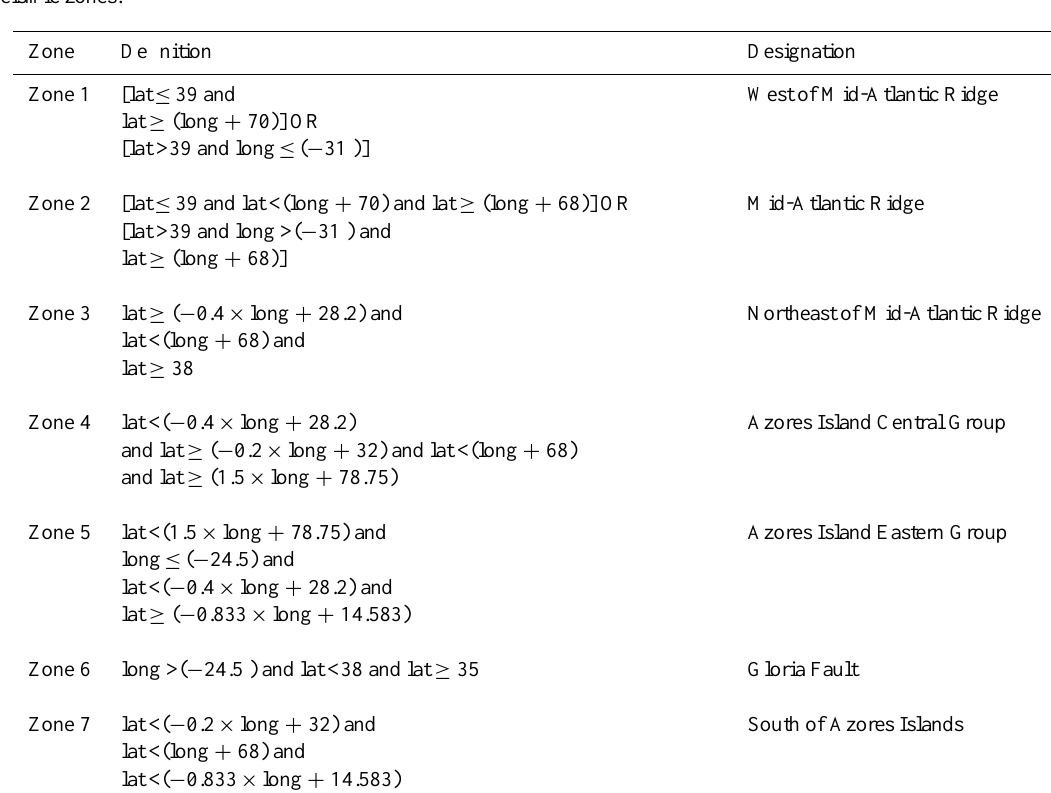
Table 5. Seismic